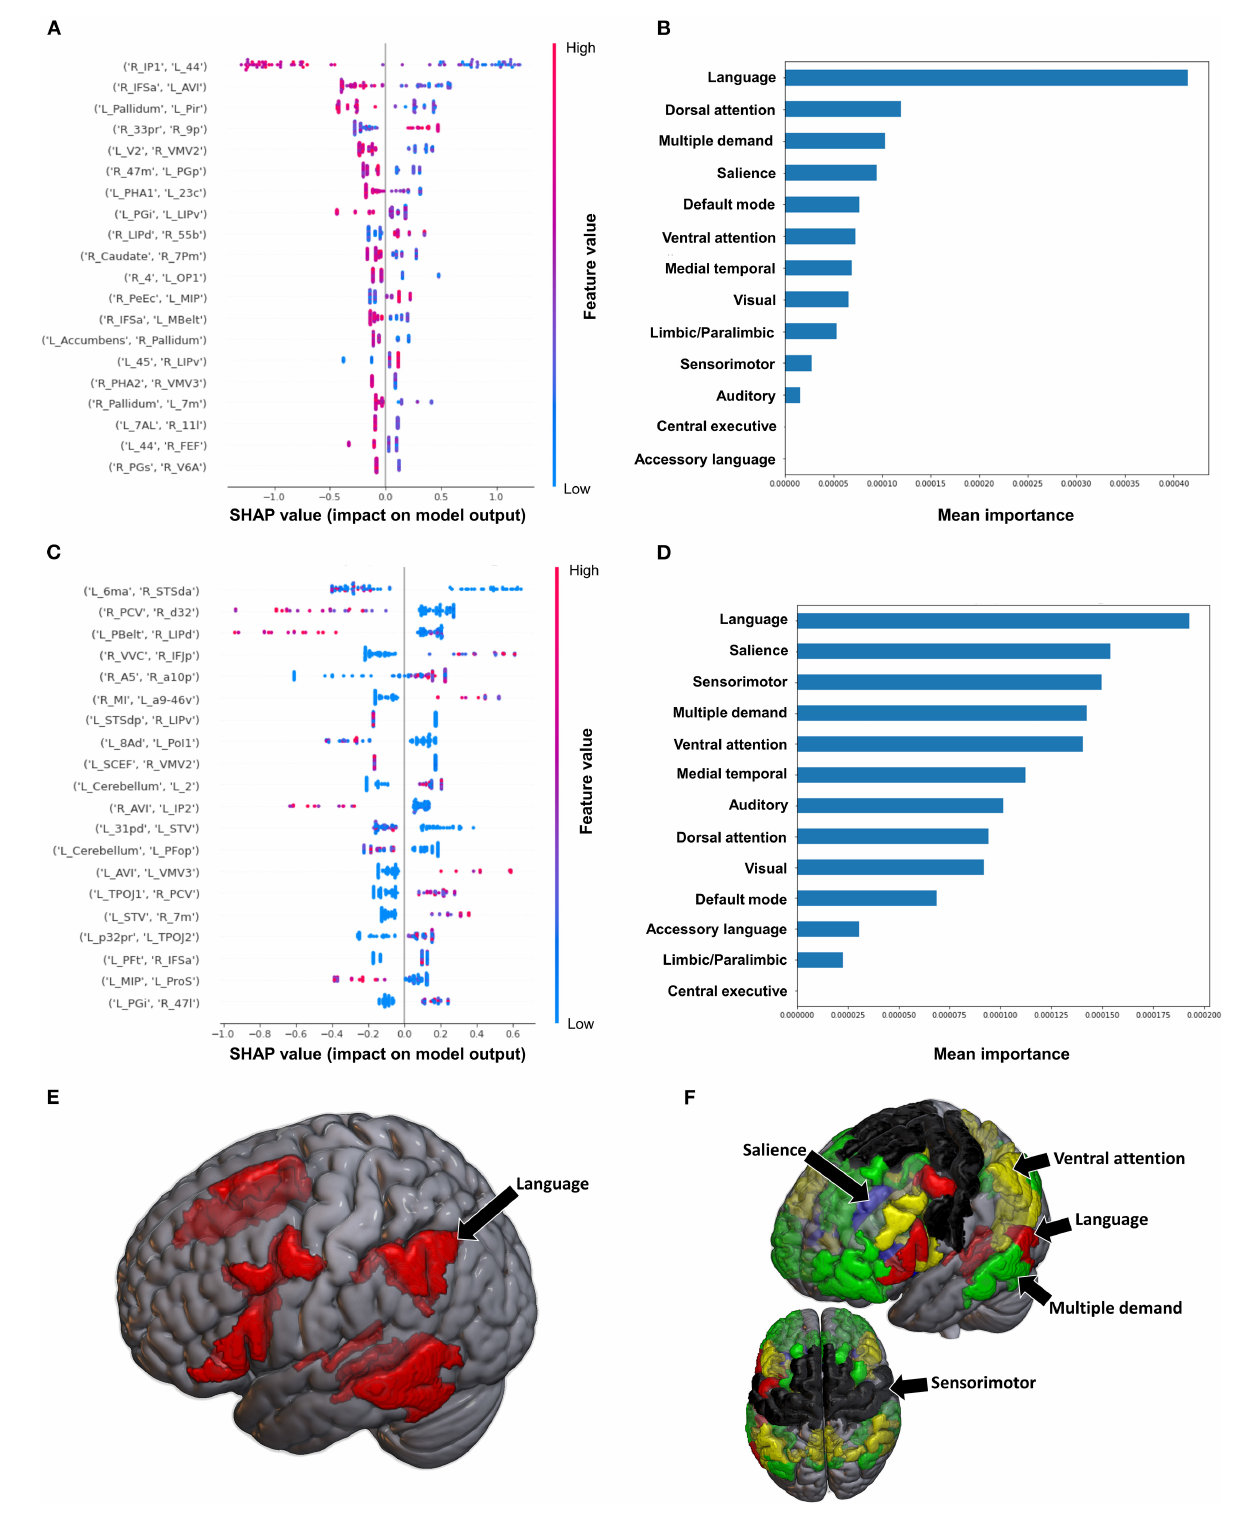
FIGURE7 Feature Importance Analysis of the models classifying the Semans balance scale based on functional connectivity at the (A) individual brain region level, and (B) the network level; and based on structural connectivity at the (C) the individual brain region level, and (D) the network level. The networks contributing most to the models’ classifications, based on (E) functional connectivity, and (F) structural connectivity, have also been visualized on brain